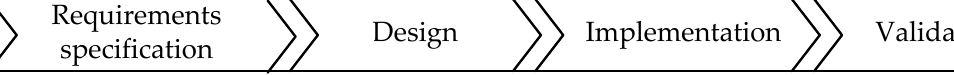
Figure 4. XMECA application stages.